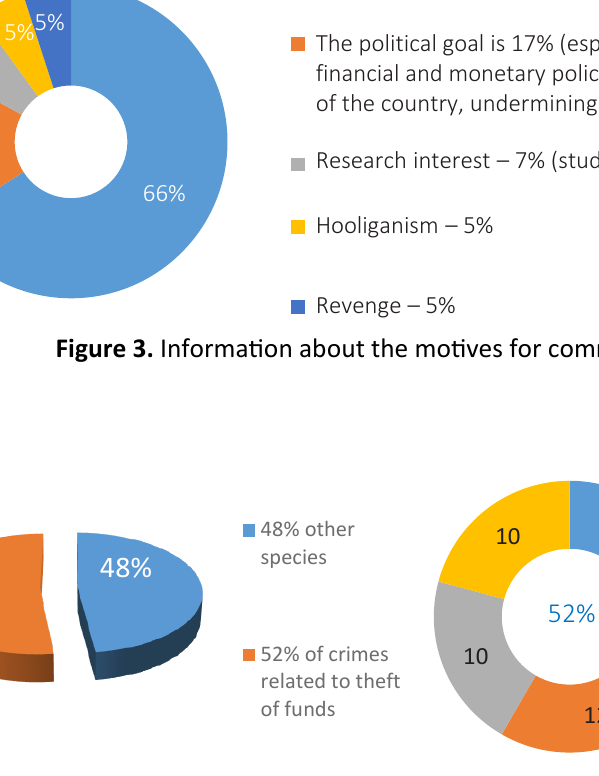
Figure 4. Information about the method of committing crimes related to theft of